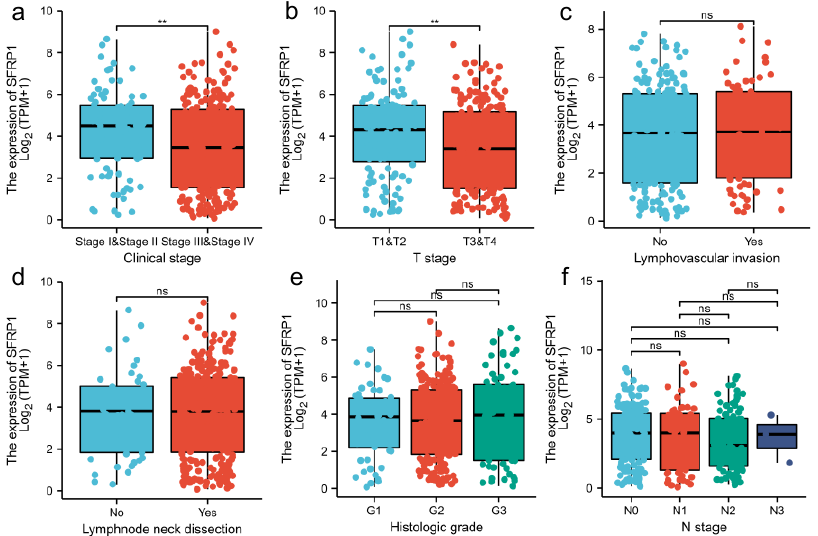
Figure 3. Association of SFRP1 expression with clinicopathologic characteristics. ( a ) Clinical stage; ( b ) T stage; ( c ) lymphovascular invasion; ( d ) lymph node neck dissection; ( e ) histologic grade; ( f ) N stage. All data are represented by mean ± SD and ns means non significance, ** p < 0.01.